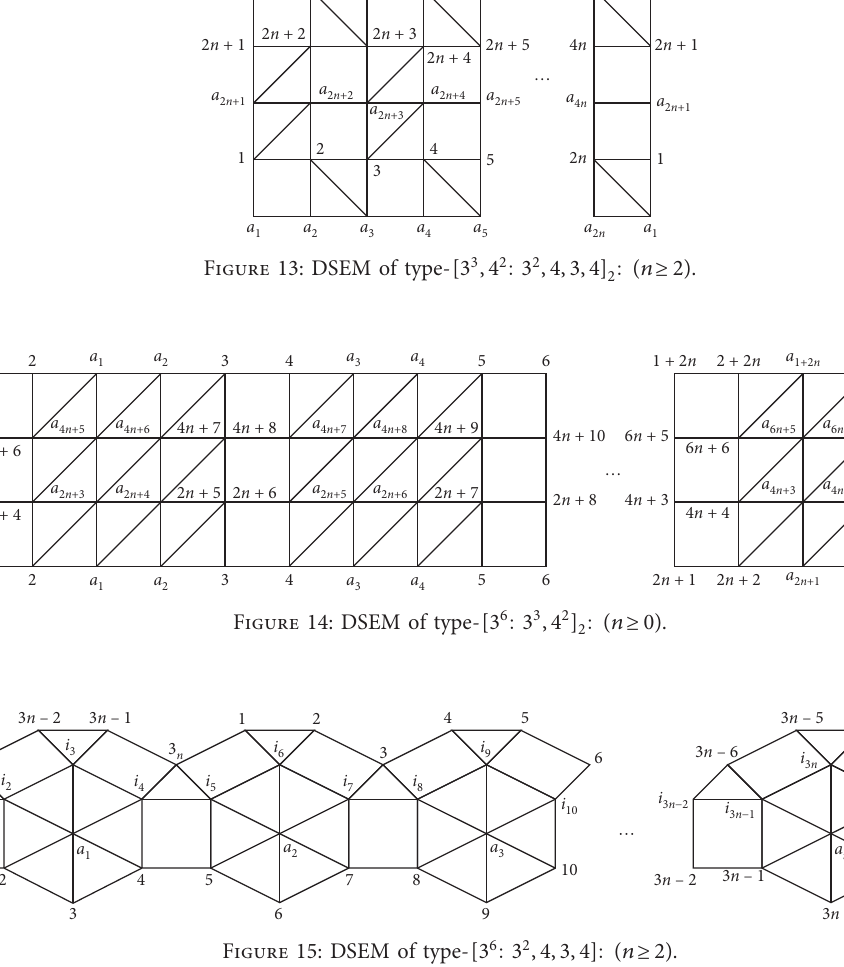
Figure 15: DSEM of type- [ 3 6 : 3 2 , 4 , 3 , 4 ] : ( n ≥ 2 )